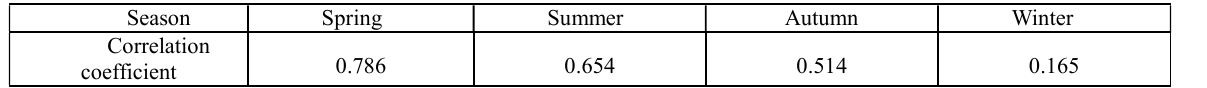
Table 8. Relation between precipitation and temperature from 2014 to 2016